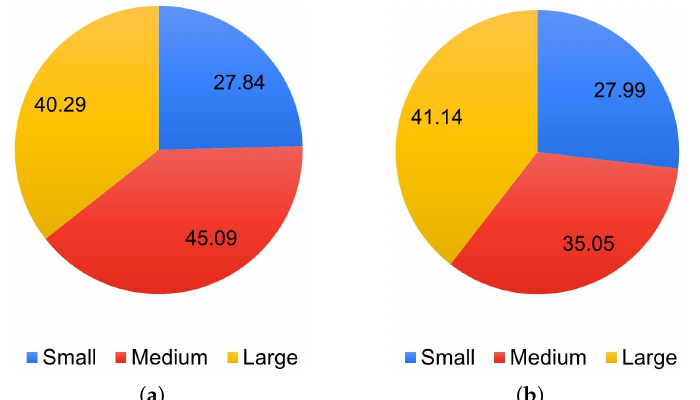
Figure 8. Monthly average consumption of domestic refrigerators inventoried in the SICEX database according to climate class: ( a ) Tropical [T] and ( b ) Sub Tropical [ST], in